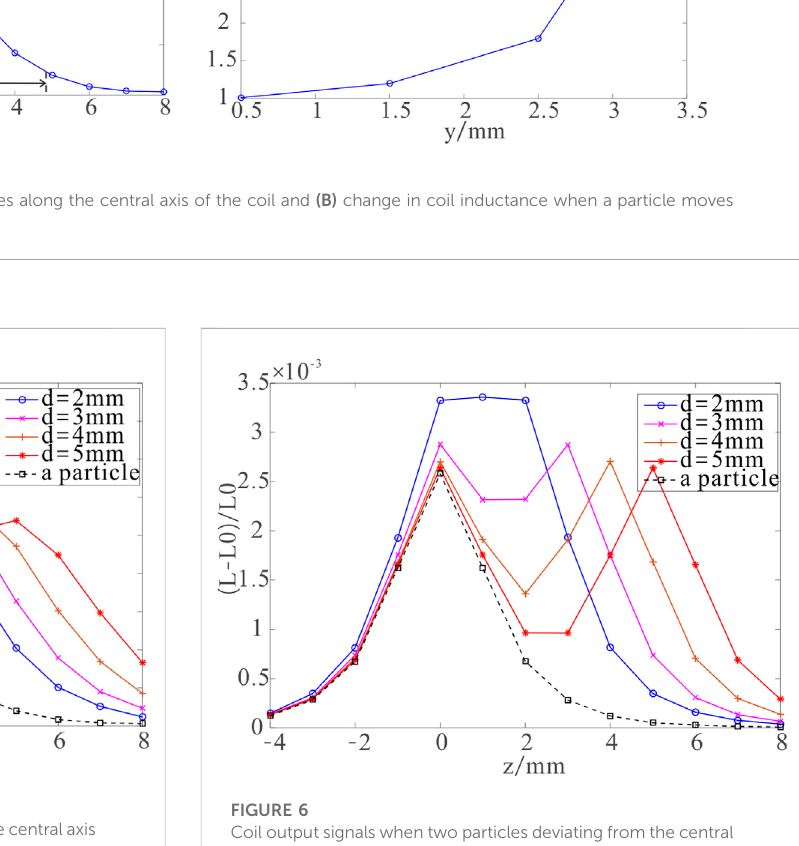
fi eld in the coil excited with a 2A alternating current is shown in Figure 3. The excitation frequency is set to 150 kHz, and the initial inductance of the coil is calculated as L 0 . As iron particles pass through the coil, corresponding disturbance of the magnetic fi eld leads to changes in coil inductance.